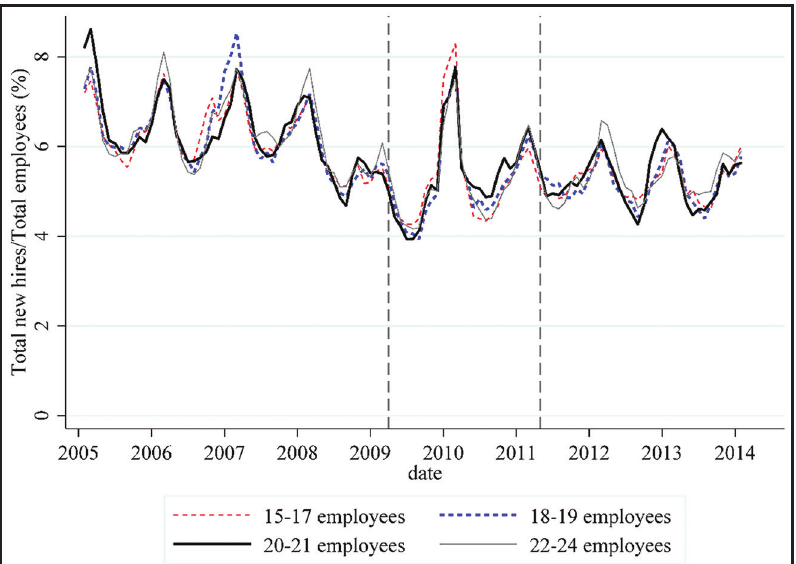
Figure 4 New hires as a percentage of total employees by firm size.